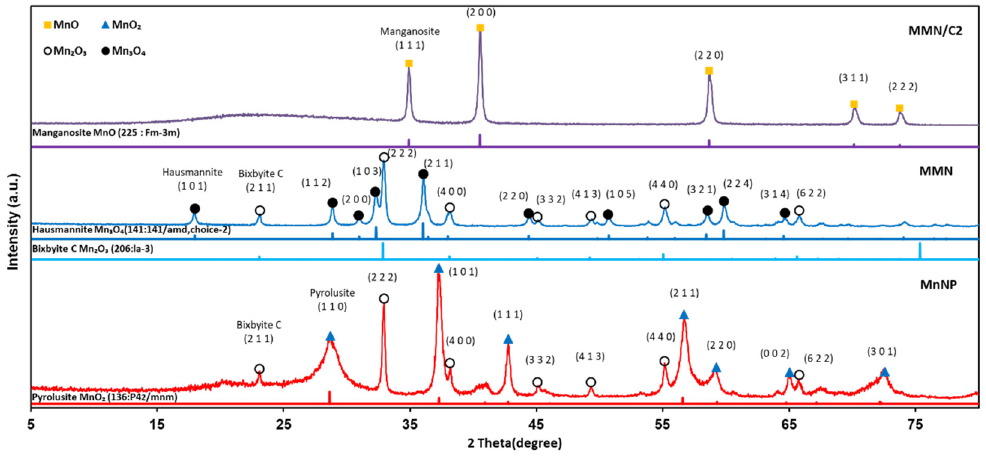
Figure 2. XRD patterns of manganese oxide nanoparticles (MnNPs), MMN, and MMN/C2 composite.